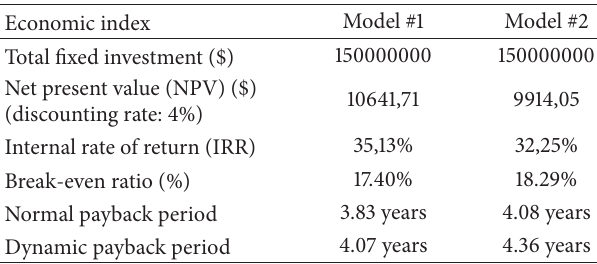
Table2:Comparisonofresultsbetweentwoconditions(COMFAR’s